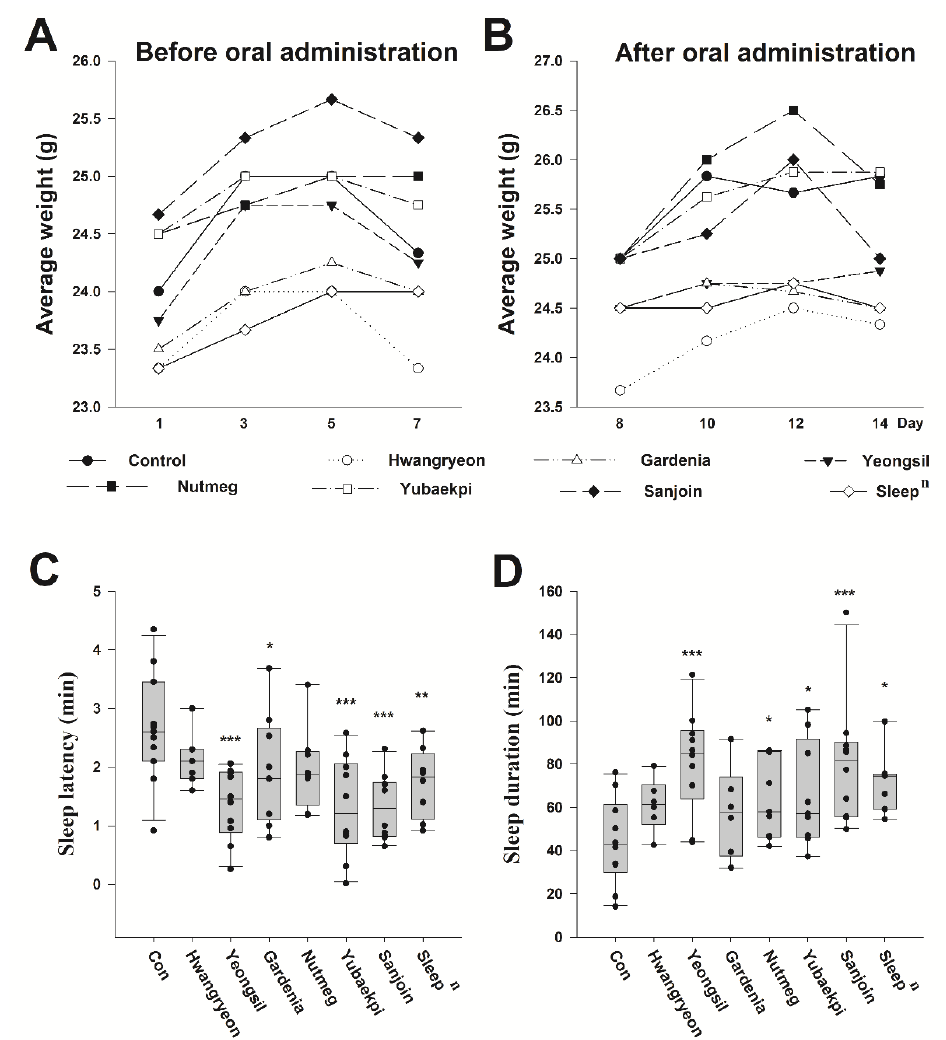
Figure 2. Changes in mice according to natural product intake. Changes in body weight of mice before taking Traditional Korean Medicine ( A ) and after starting oral administration ( B ). The sleep latency of mice fed once a day for seven days at 50 mg/kg ( C ) and the sleep duration result ( D ). For ( A , B ), the average value of each group was used. Significance was verified through one-way ANOVA, and significance was obtained between groups by post hoc testing using the Fisher-LSD method. The control group was administered saline in the same volume. *** p < 0.001, ** p < 0.01, * p < 0.05.